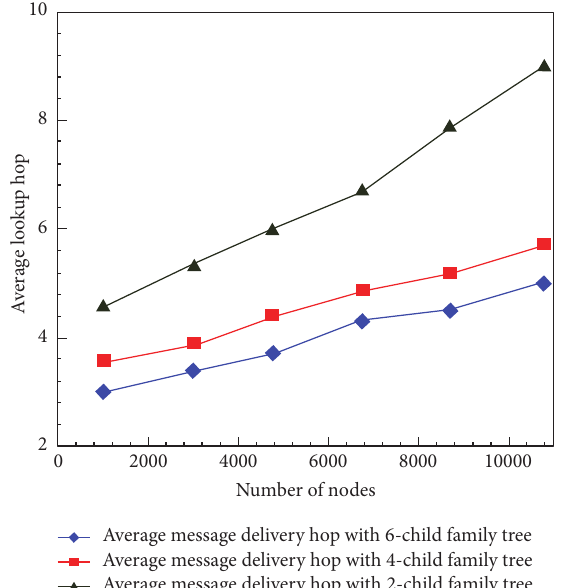
Figure 4: Average lookup hop count with different degree of family tree.